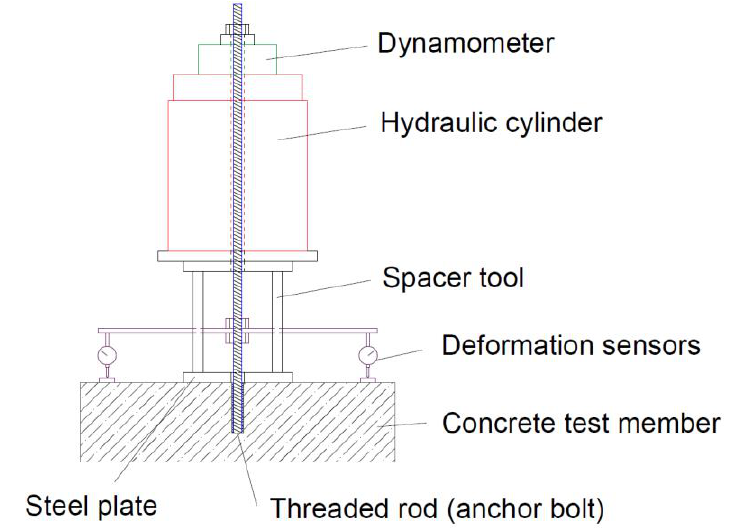
Figure 1. The principle of the confined test of bond strength. It is the similar configuration as for confined test according to the standard ETAG 001 [7].